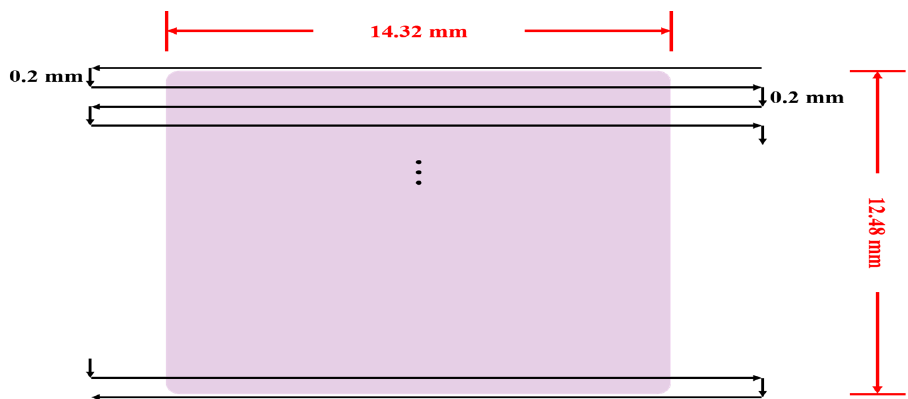
Figure 7. Schematics of up-milling ( left ) and down-milling ( right ).